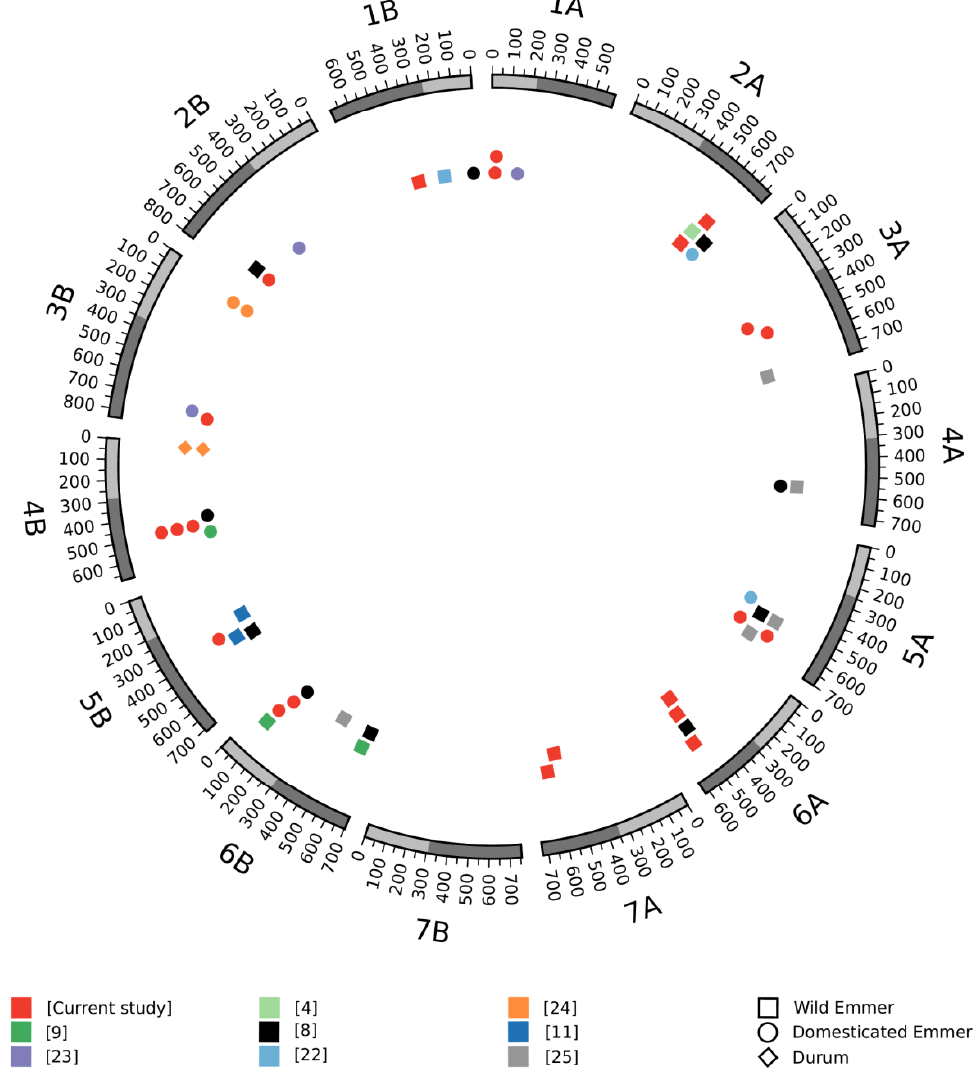
Figure 1. Meta-analysis of TKW quantitative trait loci (QTLs) from nine independent studies, using the wild emmer wheat (WEW) genome assembly as an anchor. The outer circle represents the WEW genome and the colored shapes in the inner circle represent QTLs for TKW from each of the nine studies. The different shapes (square, circle, and diamond) represent the origin (WEW, domesticated emmer wheat (DEW), or durum) of the high-TKW allele.